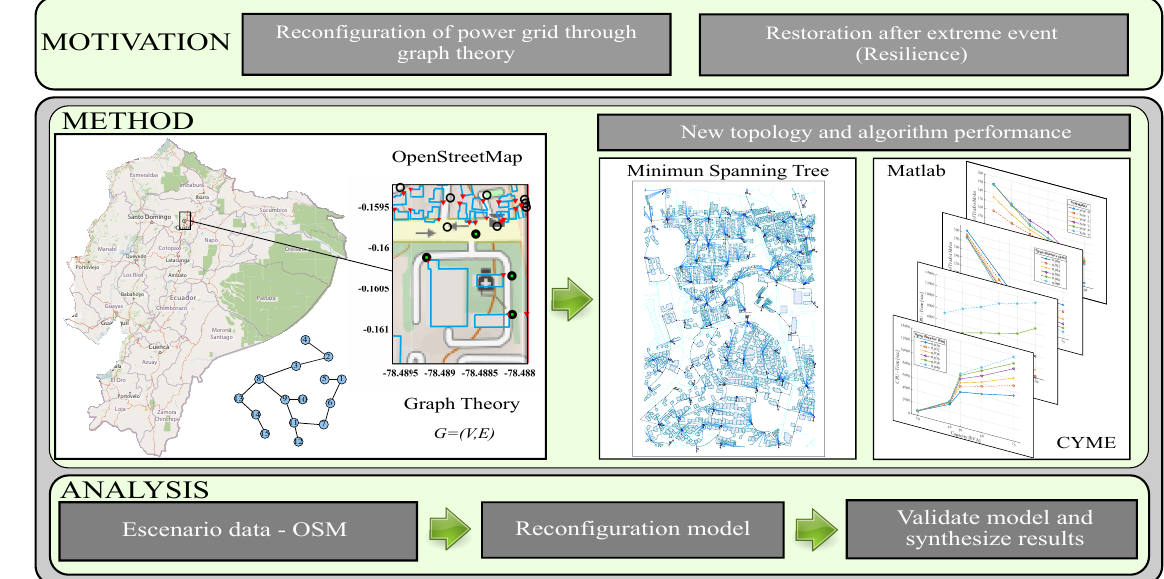
Figure 1. Proposed methodology for the reconfiguration of power